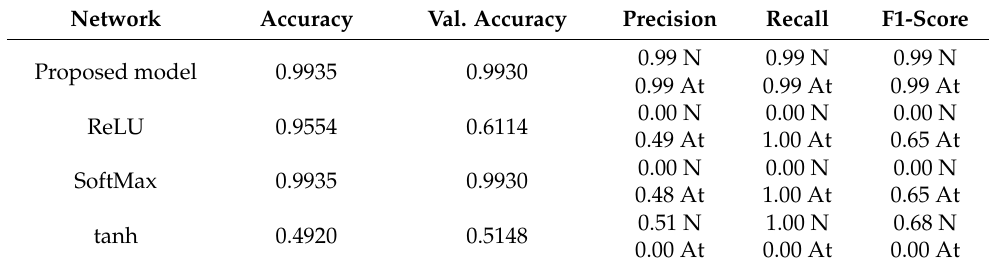
Table 5. BDLSTM-autoencoder model DDoS detection results for four activation function models. Network